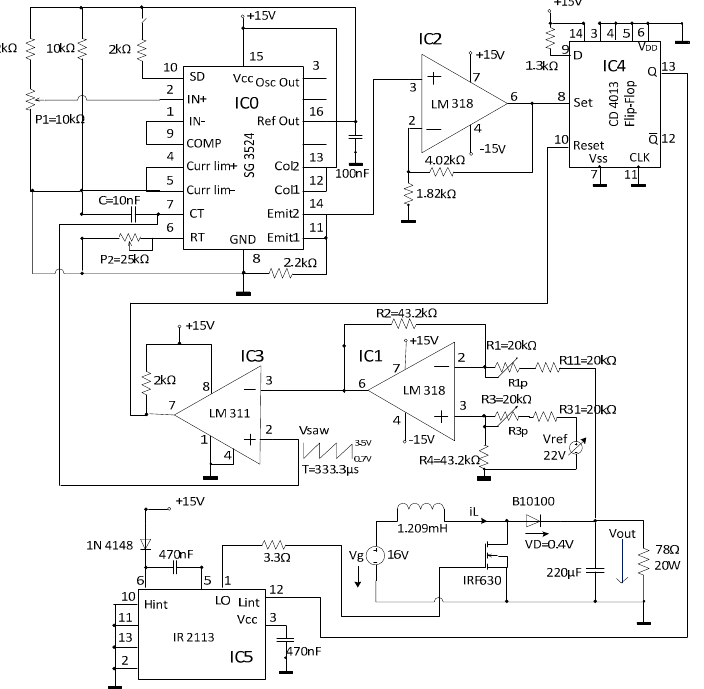
Figure 9. Schematic of the experimental boost DCM converter employing proportional voltage-mode control.